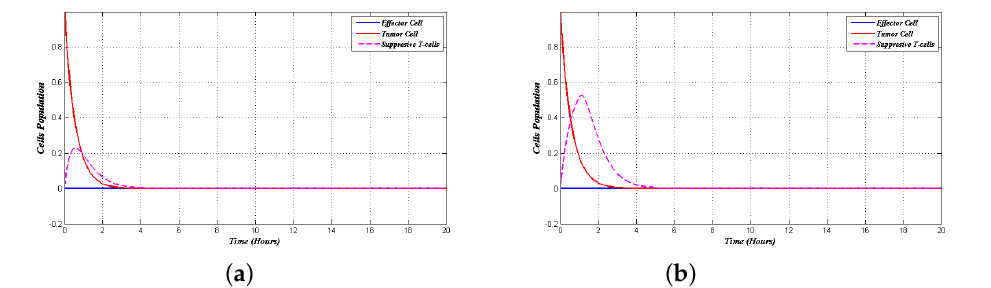
Figure 1. Solution of System (1) when conditions for global stability of tumor-present steady-state with hyperthermia treatment, i.e., when α = θ = , δ = ϑ is implemented using parameter values in Table 2. ( a ) τ = 0 ( b ) τ > 0.